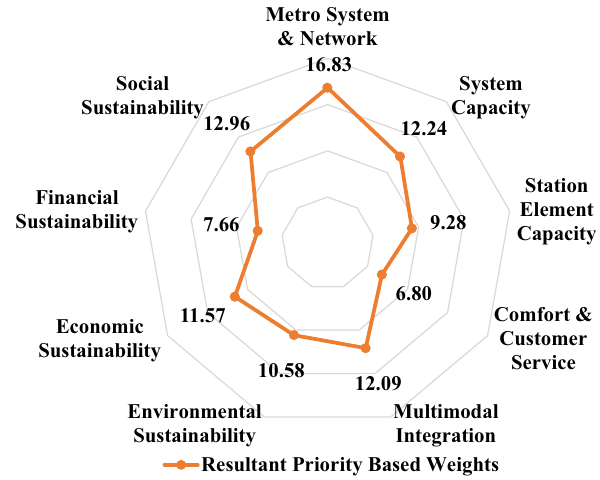
Fig. 3 Resultant priority-based weights of PIs by AHP through